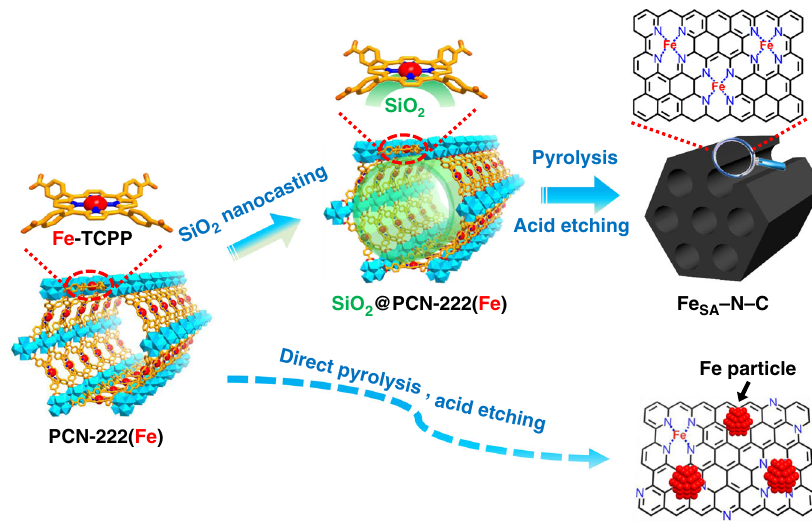
Fig. 1 Schematic illustration. Illustration showing the nanocasting-assisted fabrication of Fe SA – N – C from PCN-222(Fe).